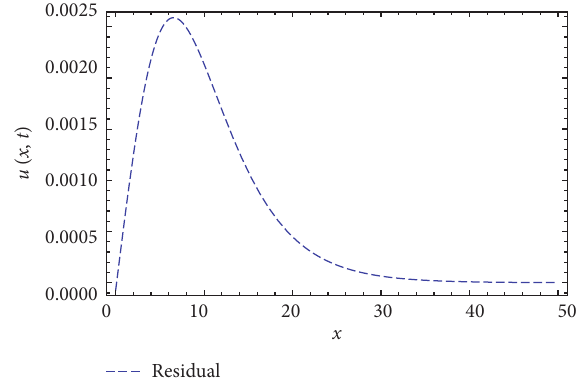
Figure 1: Residual of ζ ( η ,t ) by OHAM-DJ at t � 0 . 1.